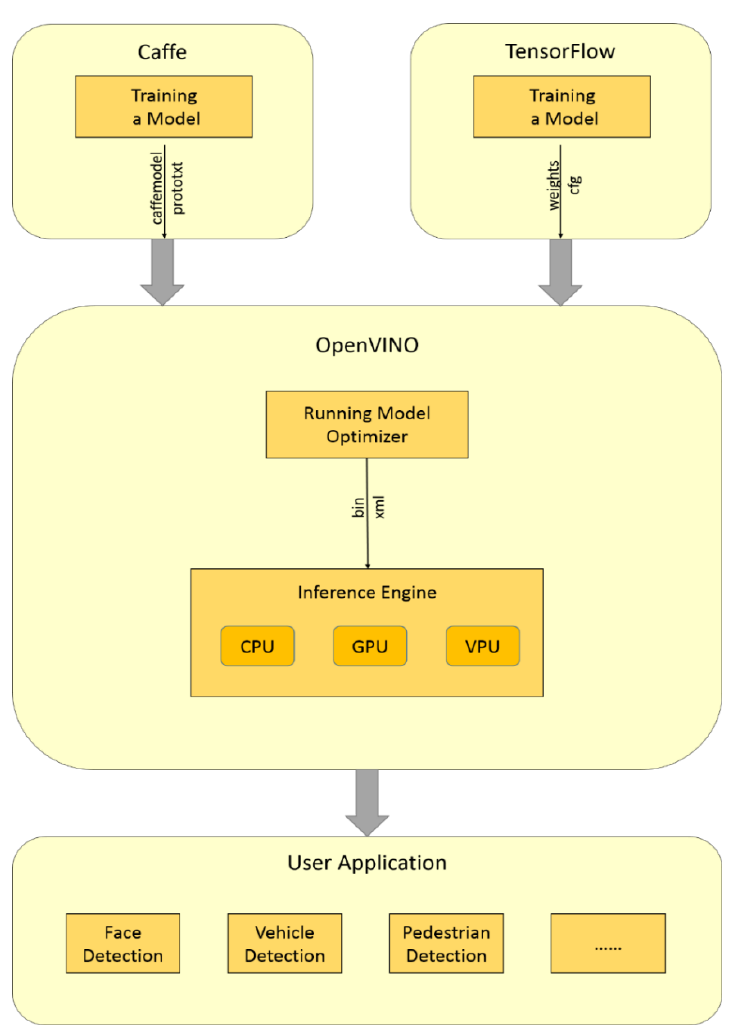
Figure 4. Model optimization with OpenVINO.